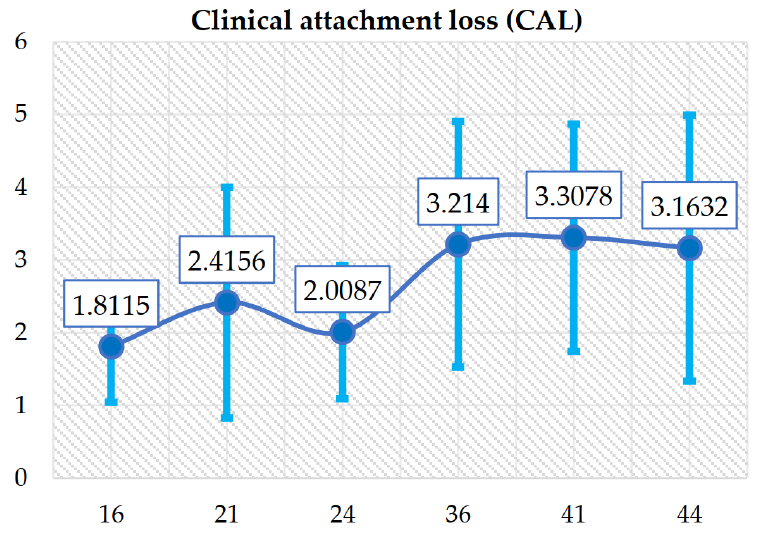
Figure 3. CAL mean value distribution on Ramfjord teeth.